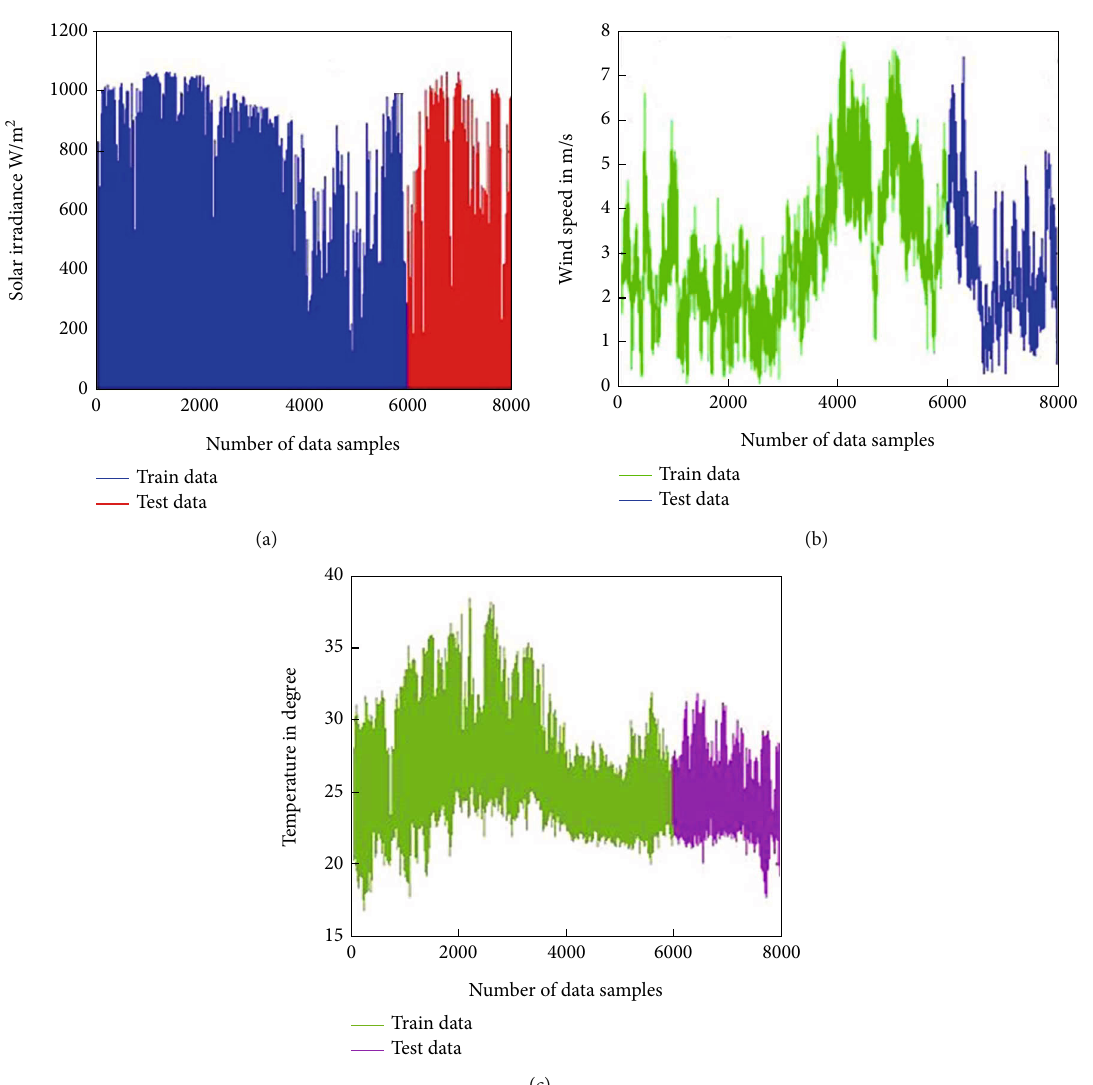
Figure 3: Dataset of the tested and trained (a) solar radiation (b) wind speed (c)